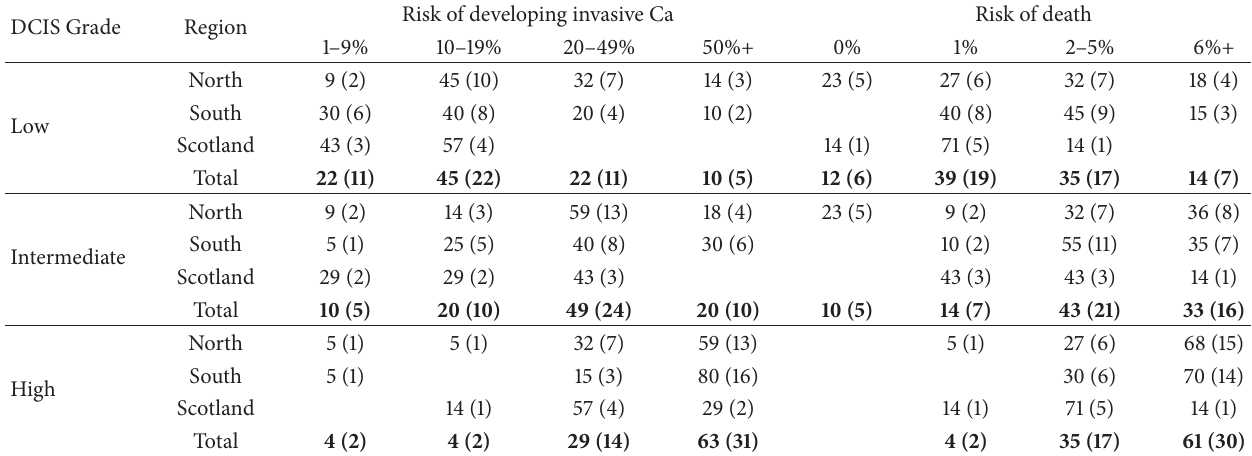
Table 3: Geographical differences in perceived prognosis for each DCIS grade (percentage in each group ( 𝑛 )). DCIS